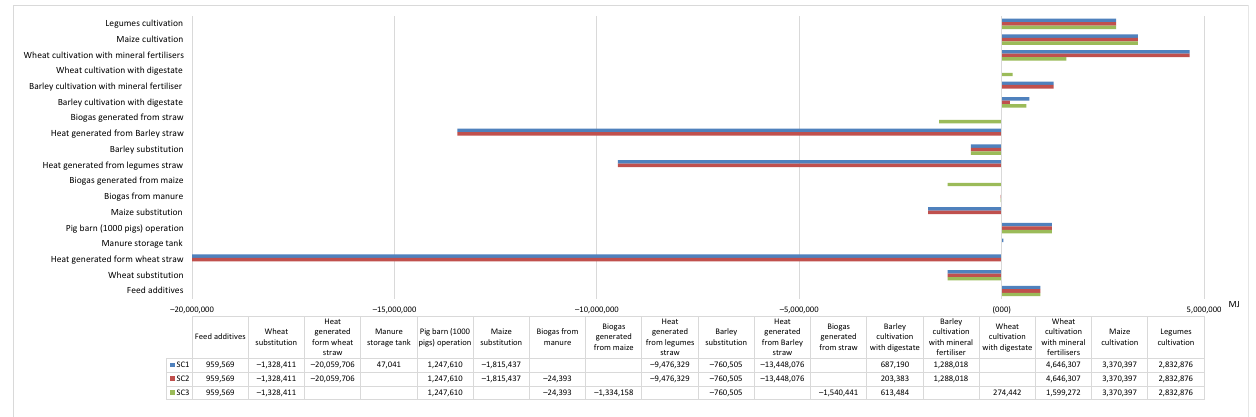
Figure 7. Results of processes for the abiotic depletion fossil fuel